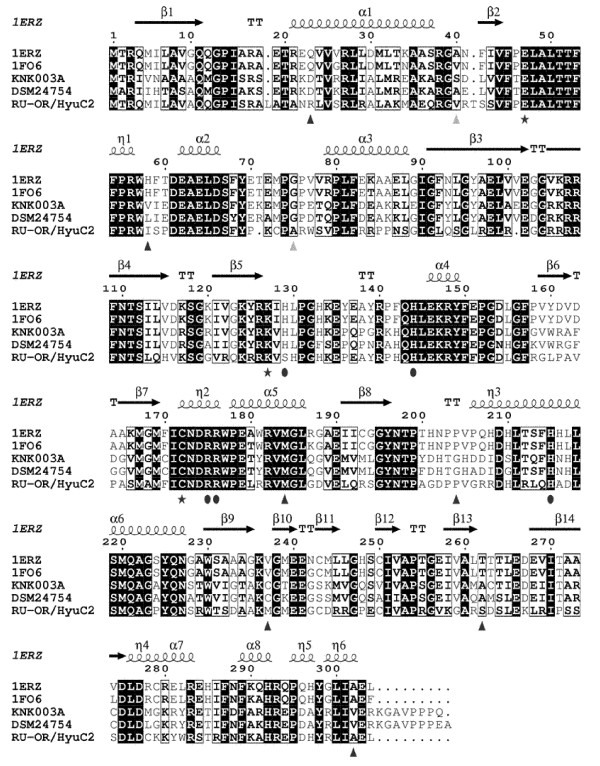
Alignment of primary amino acid sequences of the non-putative D-carbamoylases of Agrobacterium tumefaciens RU-OR (HyuC2; ABS11194.1), Pseudomonas sp. KNK003A (BAD00008.1), Agrobacterium radiobacter NRRL B11291 (1FO6), Agrobacterium sp. KNK712 (1ERZ) and the deduced carbamoylase sequence of Aminobacter sp.DSM24754. The dark shading symbolizes identical residues while bold letters represents similar residues. (⋆) residues identified as catalytic triad, () residues assumed to play a key role in substrate recognition (Chen et al.
2003; Wang et al.
2001; Nakai et al.
2000), (▴) residues supposed to influence thermal stability (Oh et al.
2002; Ikenaka et al.
1999; Chiu et al.
2006; Chiang et al.
2008), (▴) residues potentially influencing oxidative stability (Oh et al.
2002).